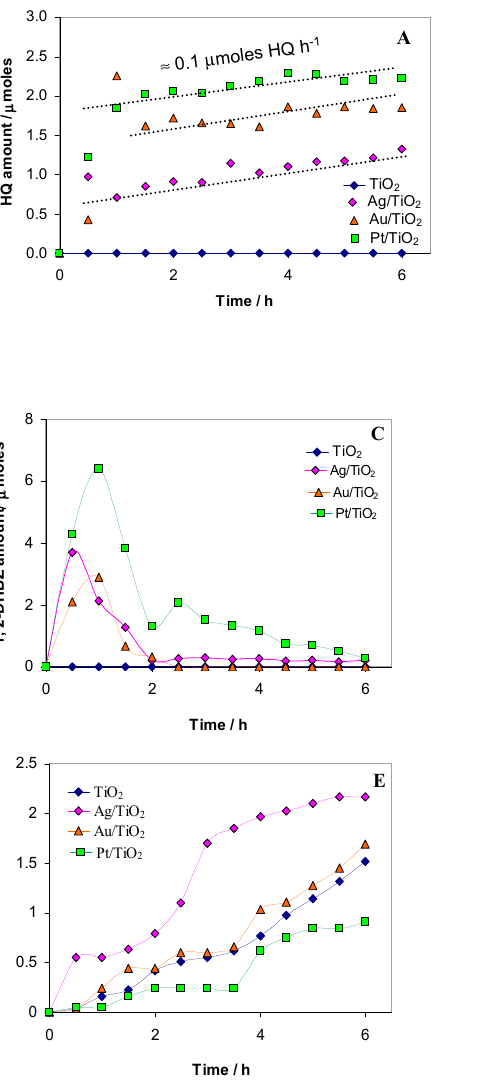
Figure 3. Solar light-driven phenol oxidative conversion to oxygenated compounds (HQ ( A ), BQ ( B ), and 1,2 DHBz ( C )), CO 2 ( D ) and to H 2 ( E ) over bare and metal modified TiO 2 synthesized by laser pyrolysis. Experimental conditions: 0.05 g suspended in 110 mL of 50 mg · L − 1 phenol aqueous solution, reaction temperature 18 °C, simulated solar light AM 1.5.